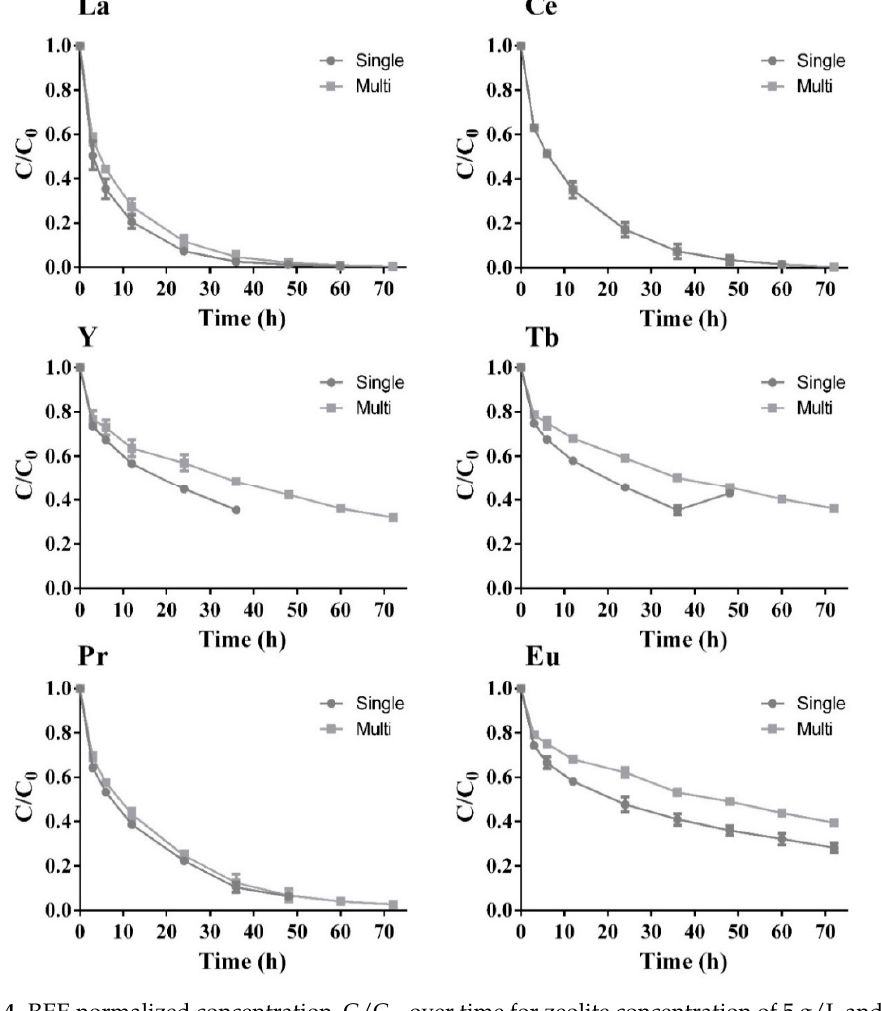
Figure 4 . REE normalized concentration, C/C 0, over time for zeolite concentration of 5 g/L and REE initial concentration of 20 mg/L for the single- ( ) and multi-component ( ) assays, with the respective standard deviation ( n = 3, X = 2).